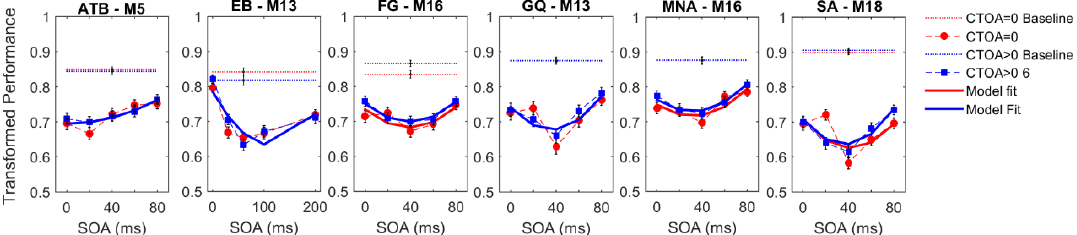
Figure A1. The transformed performance as a function of SOA for invalid trials in the exogenous attention condition for all CTOAs. The horizontal axes represent SOA and the vertical axes represent transformed performance. Red color represents zero CTOA and blue color represents positive CTOA value (ranging from 80 to 120). The dotted horizontal lines indicate baseline performance. The markers and the dashed lines represent empirical data whereas the solid lines show the best-fit regression model. Each panel shows data from a single observer. The best regression model (see Table 2) is given on top of each panel. Error bars represent ± SEM across trials (n = 100). We looked at the distribution of signed response-errors of invalid trials in the exogenous attention condition and fitted a hierarchy of statistical models described in Methods section (Section 2). The GU model was the winning model for all observers as in the valid trials presented in the main text. Figure A2 shows the model parameters for the GU model as a function of SOA and CTOA. Red color represents zero CTOA and blue color represents positive CTOA values (ranging from 80 to 120).